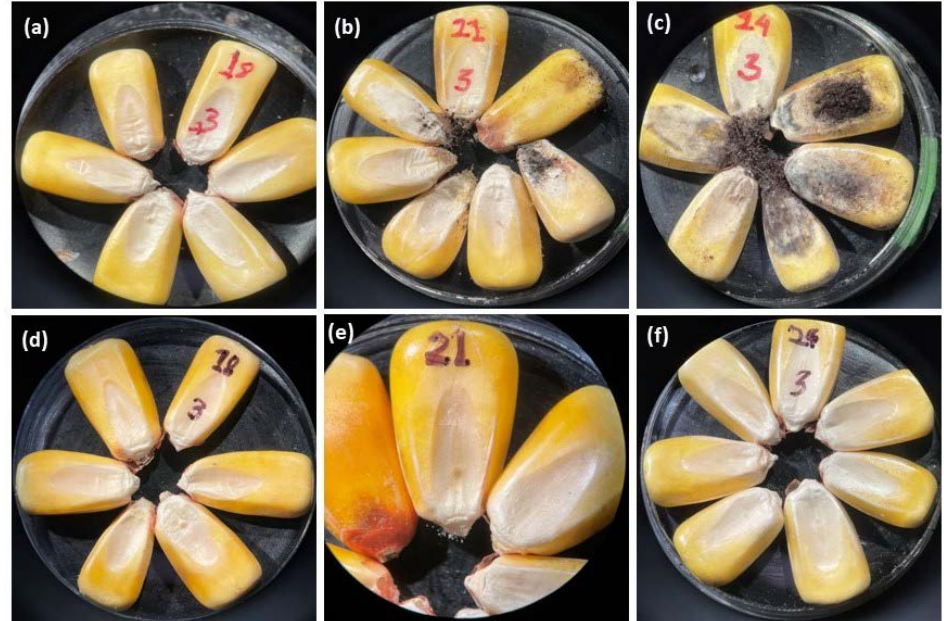
Figure 3. Pictures of maize kernels were magnified using a stereomicroscope (10×). Samples are for visual mold assessment of maize at 18, 21, and 24% moisture content stored for 21 days in non-hermetic ( a – c ) and hermetic ( d – f ) jars, respectively.